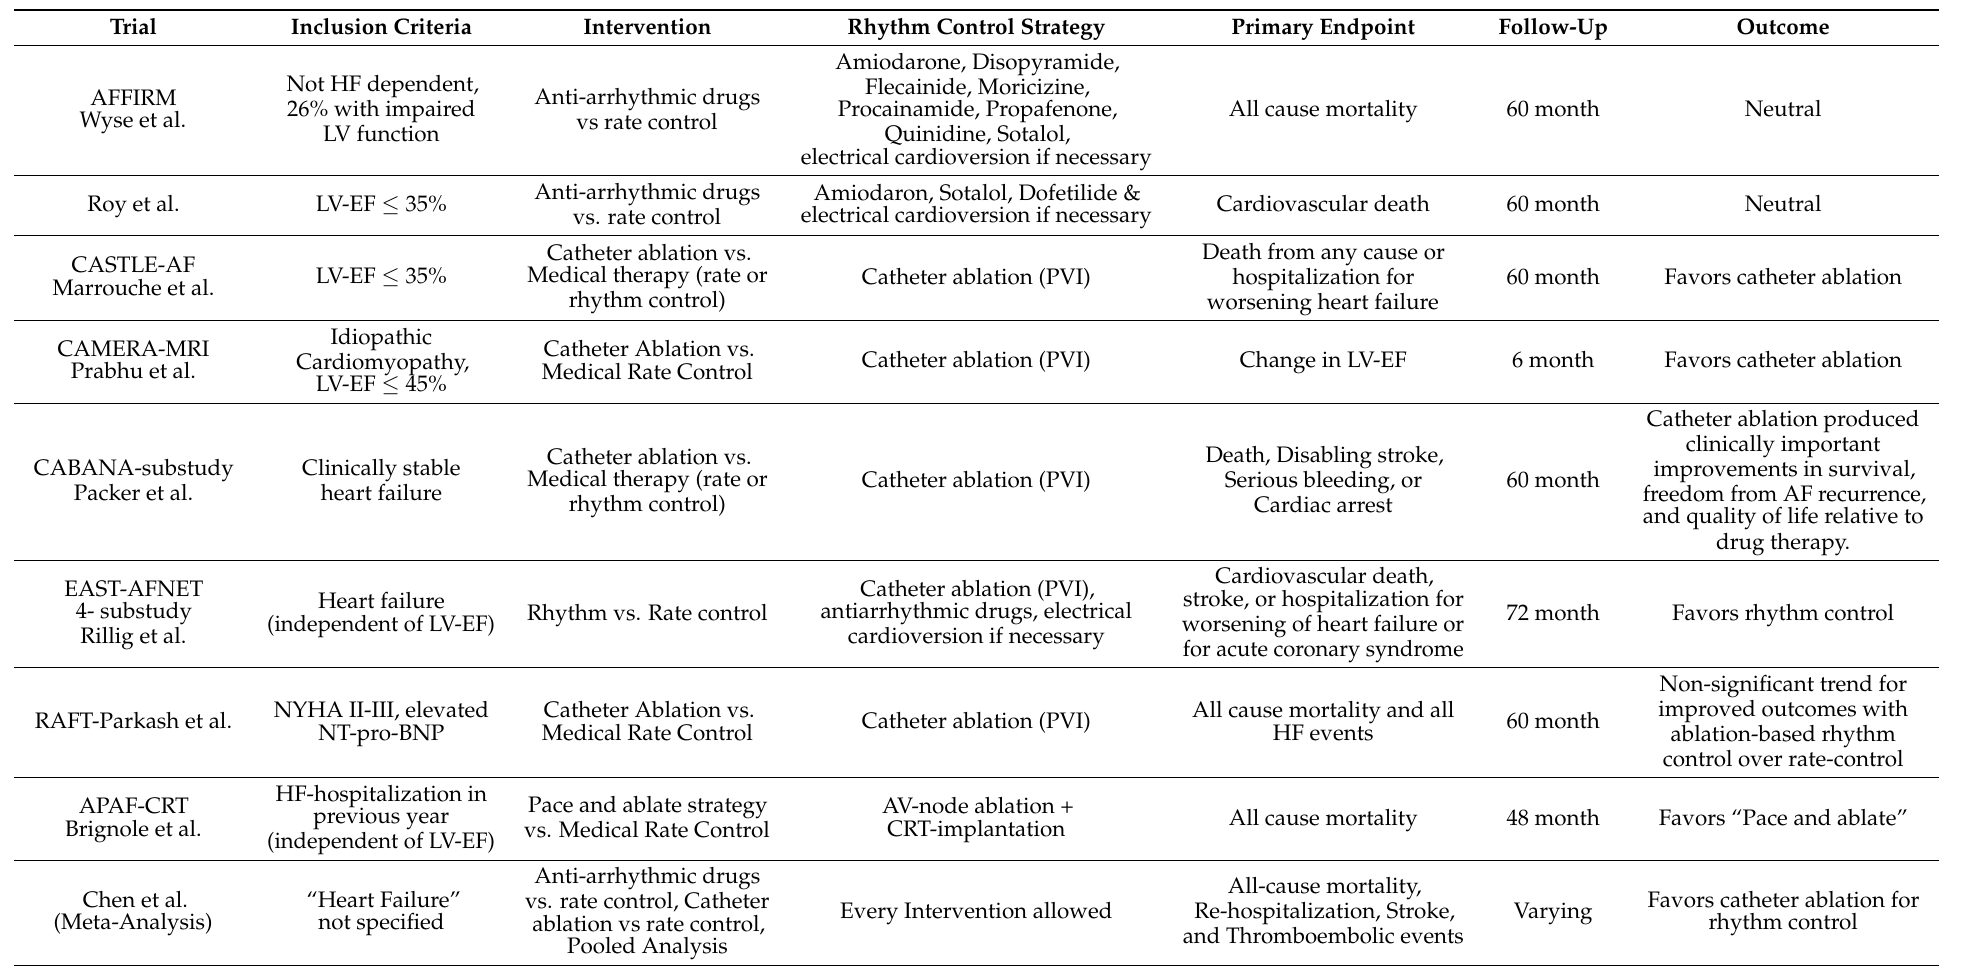
Table 1. Summary of different clinical trials reporting on outcomes of different treatment strategies in patients with atrial fibrillation and heart